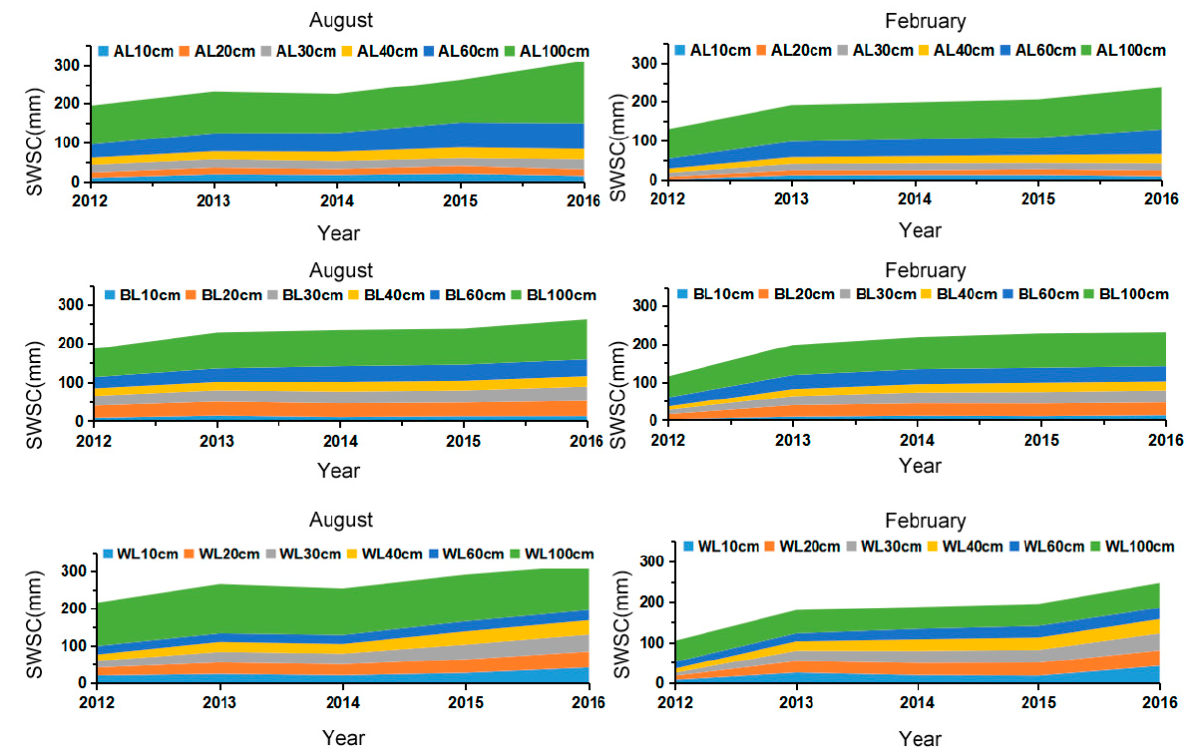
Figure 8. Soil water storage in August and February of different site types in 2012 to 2016 (SWSC: soil water storage capacity; AL: arbors forest land; BL: bush land; WL: weed land).